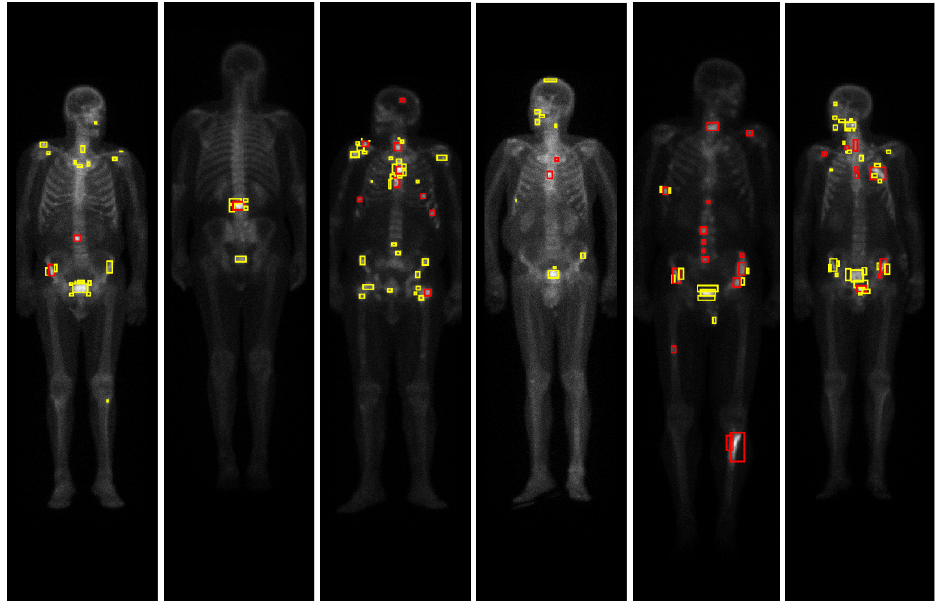
Figure 5. Results of the detection algorithm in bone scintigraphy images from the malign set. The colours of the bounding boxes were manually chosen for the purposes of illustration, according to the respective medical report of the patient: red represents metastases, green represents benign bone lesions and yellow represents false positives (hotspots that are neither malign nor benign